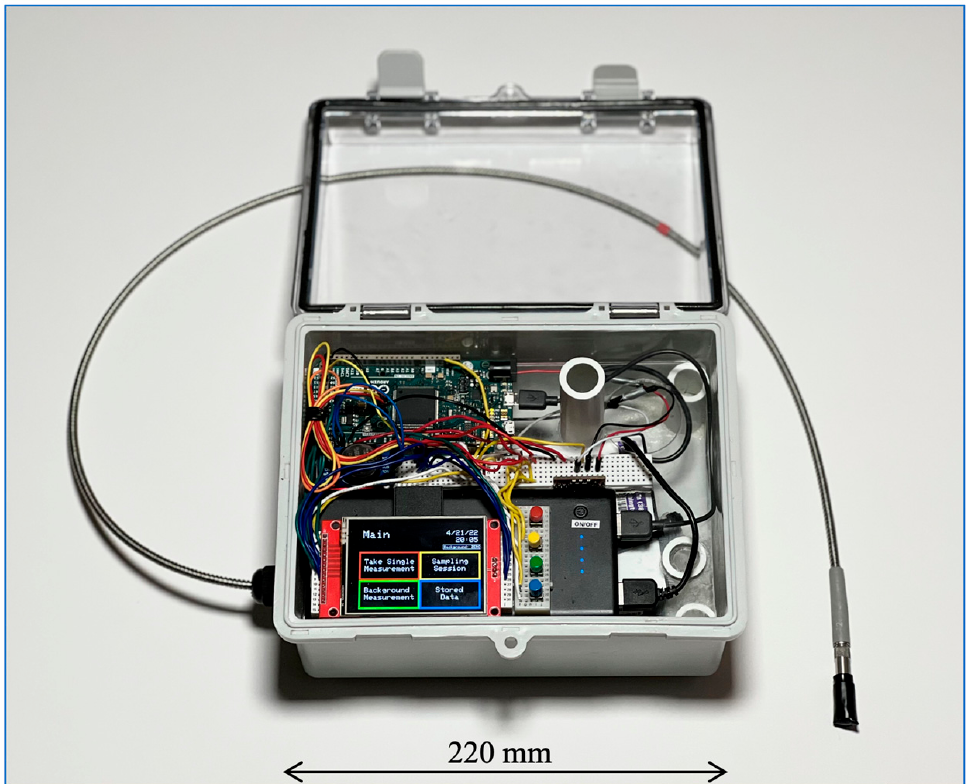
Figure 1. A top view of the wearable platform with hood open.